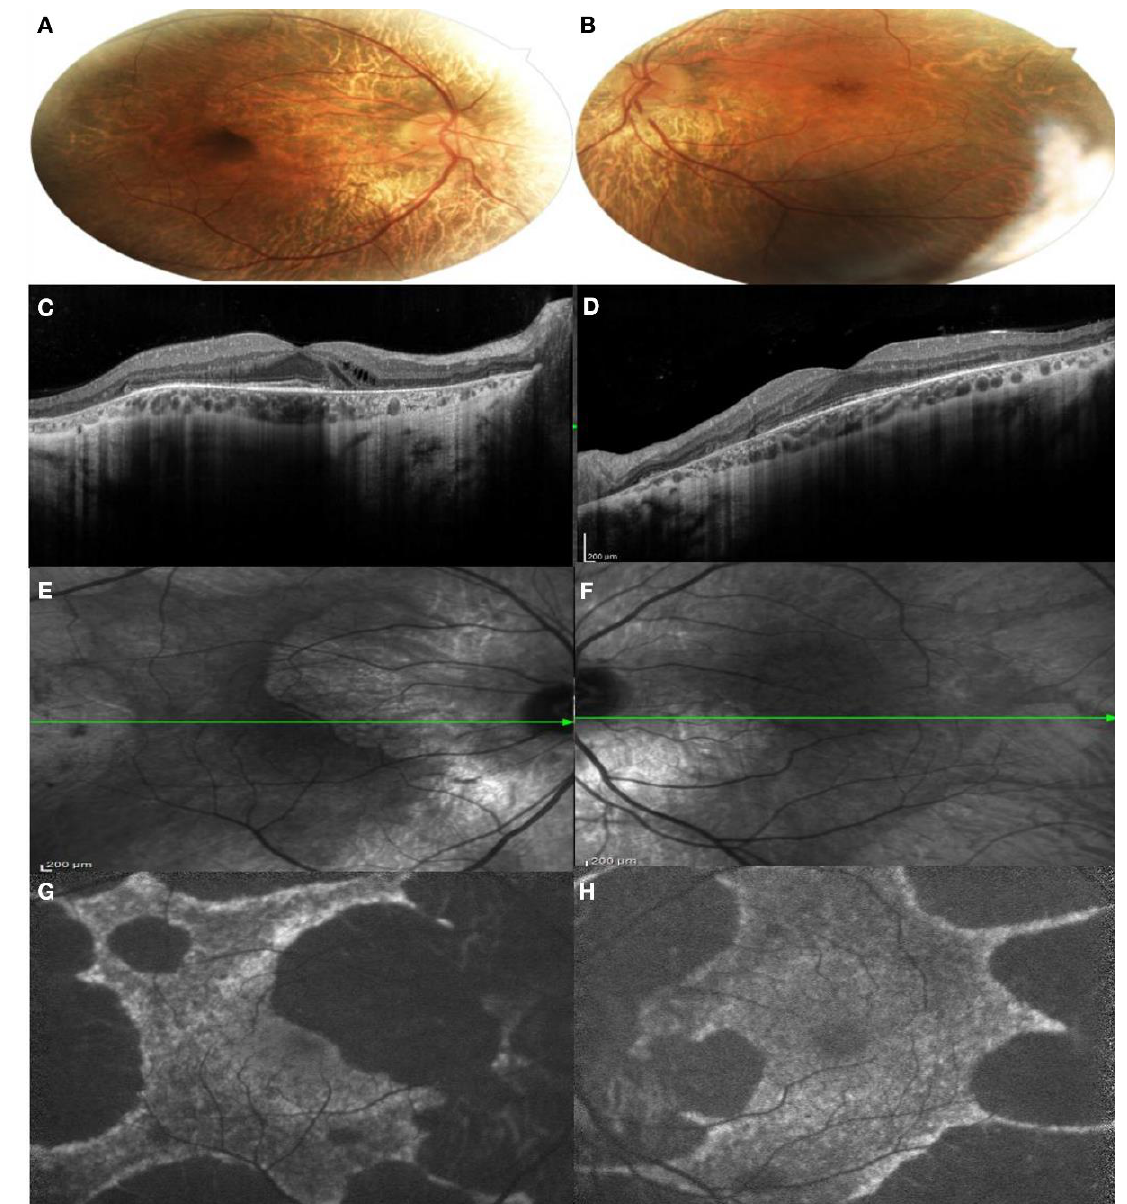
Figure 4. Multimodal imaging of both eyes of patient II:1. ( A , B ) Color fundus photography of both eyes showed large peripapillary and temporal retinal atrophy; ( C , D ) SD-OCT of both eyes showed peripapillary chorioretinal atrophy with retinal thinning and hyper-transmission posterior to the RPE. In the foveal and iuxtafoveal area, the Ellipsoid zone (EZ), RPE and all retinal layers were well-detectable; ( E , F ) IR images showed the transition of the intact RPE under the fovea to the atrophic area; ( G , H ). FAF showed central island of preserved autofluorescence. ( A , C , E , G ): right eye; ( B , D , F , H ): left eye.